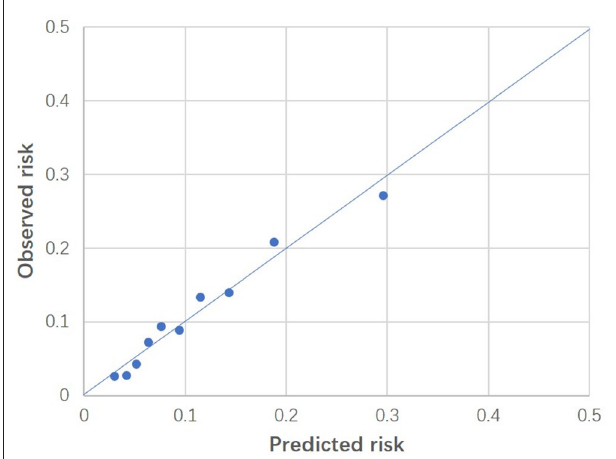
FIGURE 3 | Calibration plot of the final model. Predicted risk was indicated on horizontal axis, whereas observed risk was indicated on vertical axis. These results were based on patients grouped into deciles of predicted risk. Modified Hosmer-Lemeshow test indicated good fitness ( p =